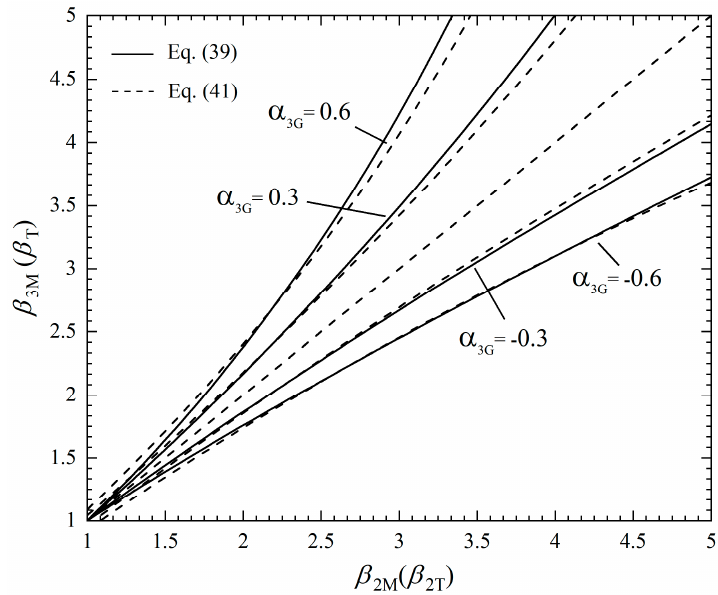
Figure 1. Precision testing of Equation (39).